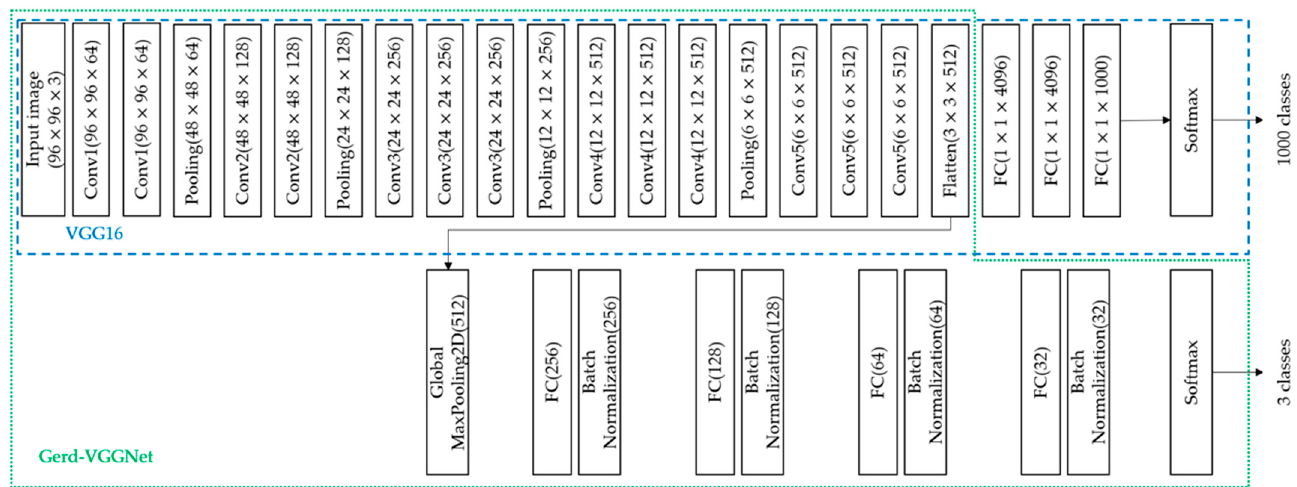
Figure 1. Gerd-VGGNet architecture.